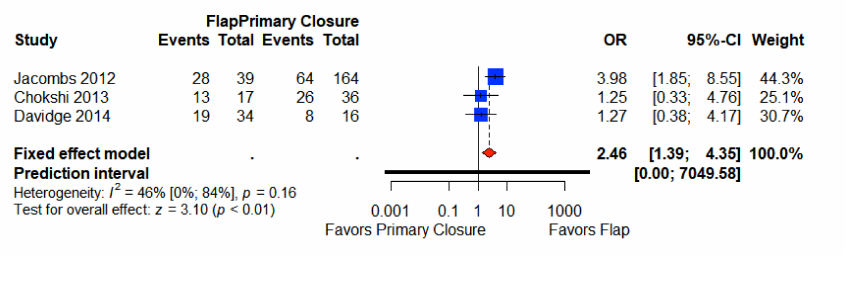
Figure 2. Forest plot for total perineal wound complications between patients with primary closure and with flap closure ( A ); forest plot for total perineal wound complications between patients with primary closure and with mesh closure ( B ); forest plot for total perineal wound complications between patients with primary closure and with flap closure in pelvic exenteration ( C ). Odds ratio: overall ratio of total perineal wound complications when comparing primary closure with flap closure. All weights are from random effects analysis. M–H, Mantel–Haenszel.